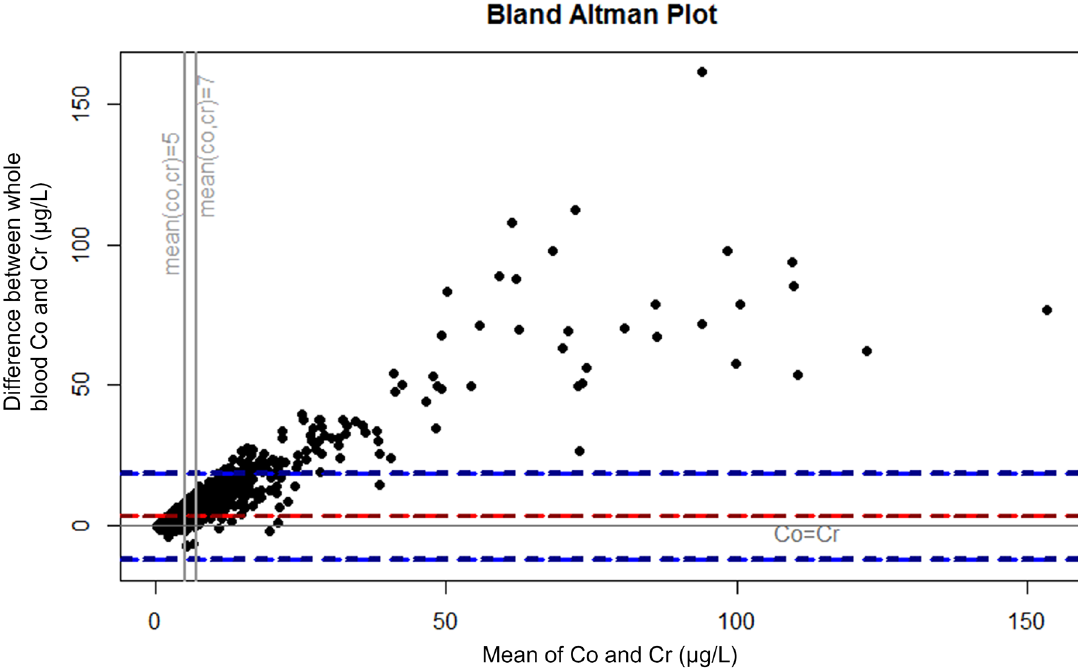
Figure 3. Bland–Altman plot representing the difference between whole blood Co and Cr in relation to the mean of whole blood Co and Cr (µg/L) in patients with unilateral or bilateral stemmed total hip arthroplasty. In the measurements below zero the whole blood Cr is higher than Co. The red line represents mean difference and blue lines 95% confidence intervals. Measurements before/without revision surgery. Figure drawn with R (Version 3.5.1) 21 .